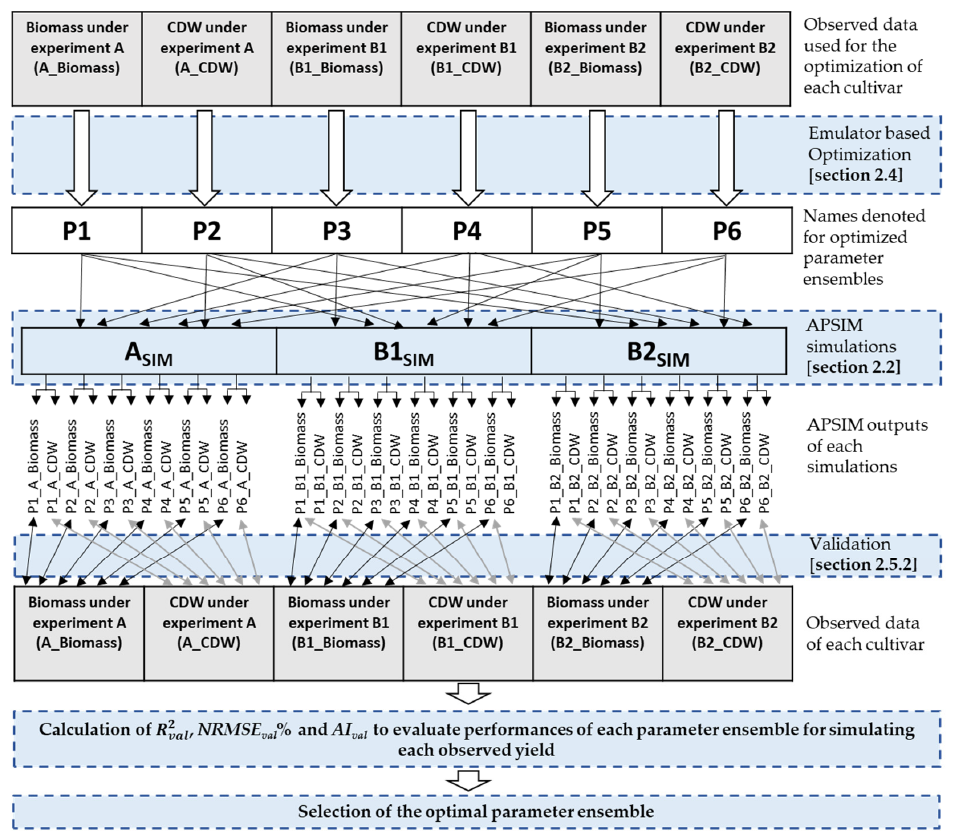
Figure 2. Process flow diagram of validation—step two. P1, P2, P3, P4, P5 and P6 represent the optimized parameter ensembles of each cultivar. A SIM , B1 SIM and B2 SIM represent the APSIM simulations described in Section 2.2.